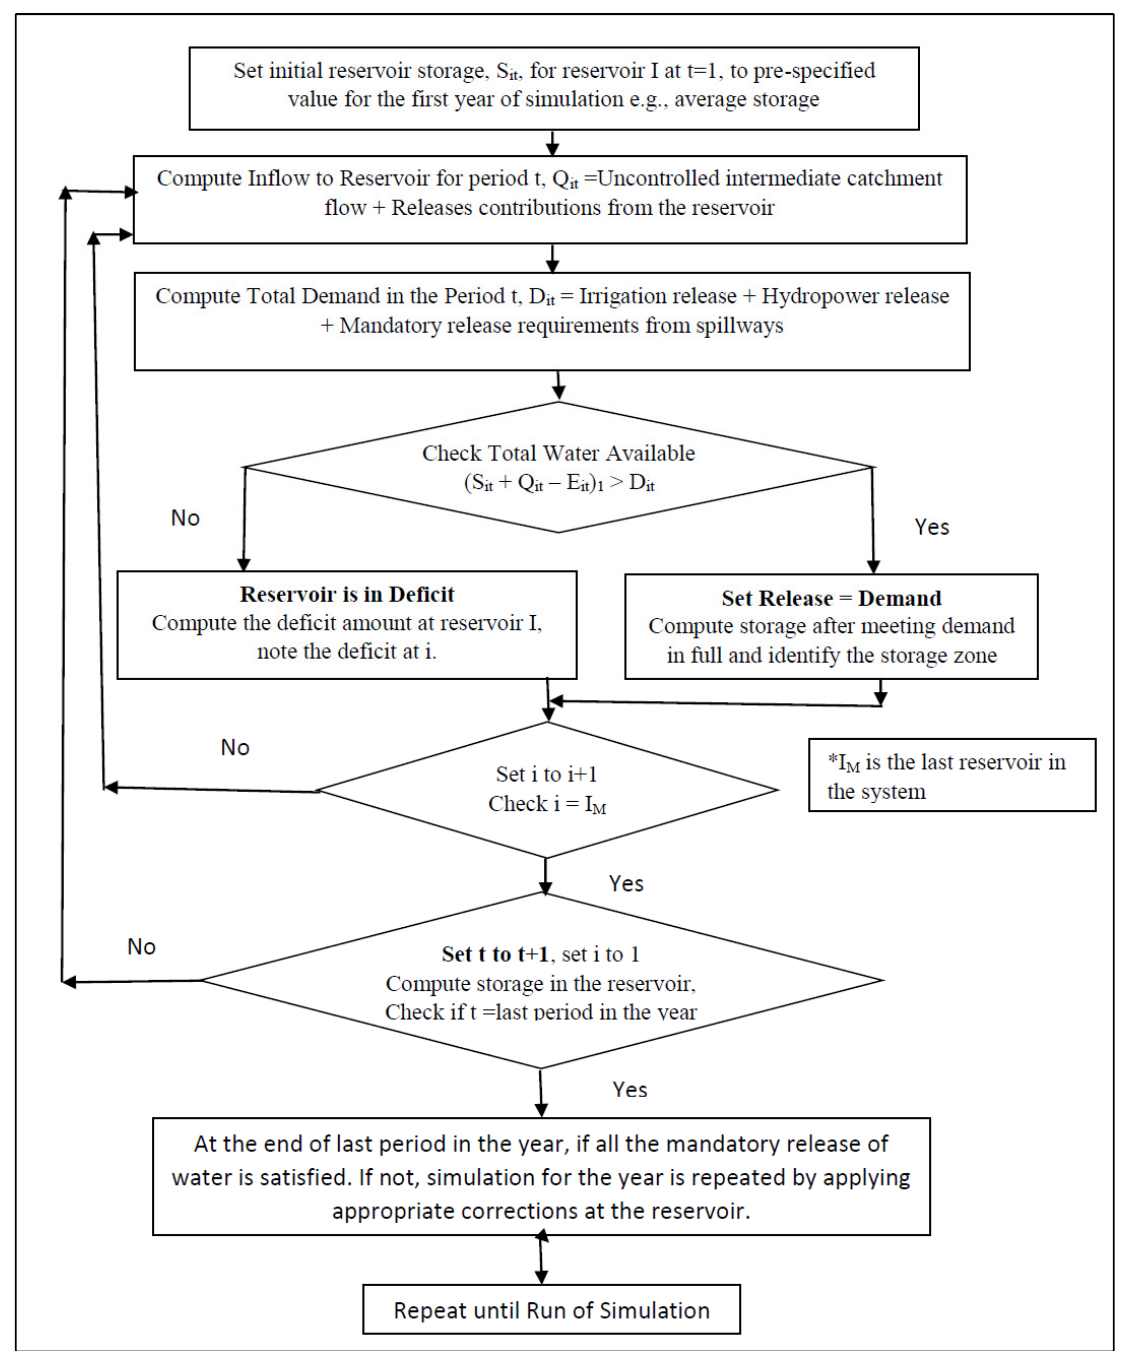
Figure 19. Flow Chart for Simulation.